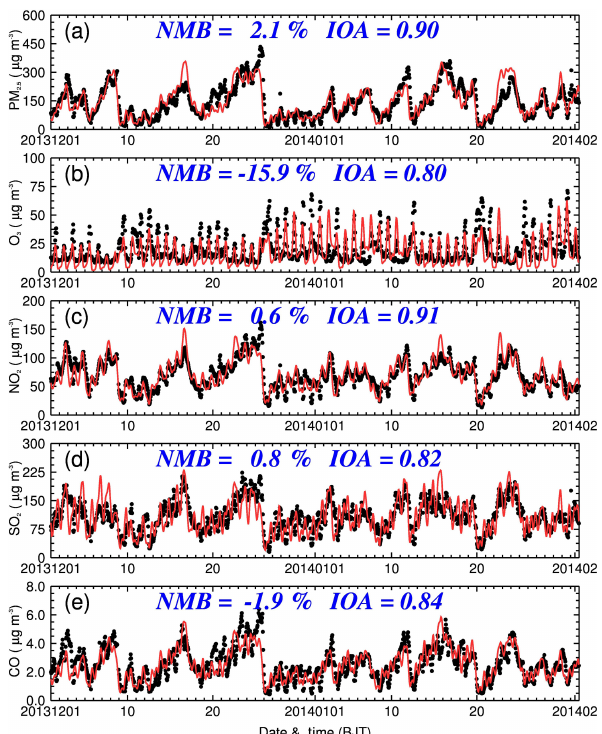
Figure 3. Comparisons of observed (black dots) and simulated (solid red lines) diurnal profiles of near-surface hourly mass con- centrations of (a) PM 2 . 5 , (b) O 3 , (c) NO 2 , (d) SO 2 , and (d) CO av- eraged at monitoring sites in BTH from 1 December 2013 to 31 Jan- uary